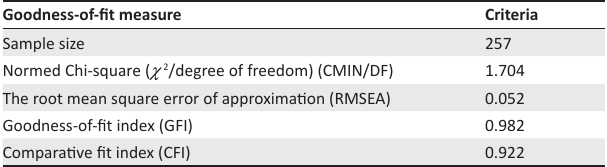
TABLE 8: Goodness-of-fit indices for transformational leadership and leadership